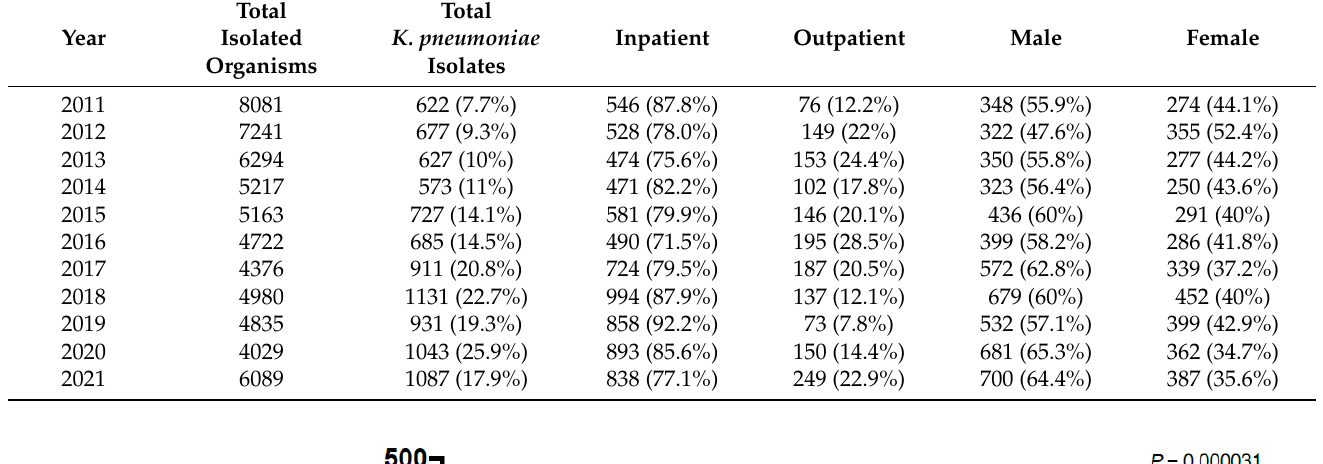
Table 1. The demographic distribution of K. pneumoniae .